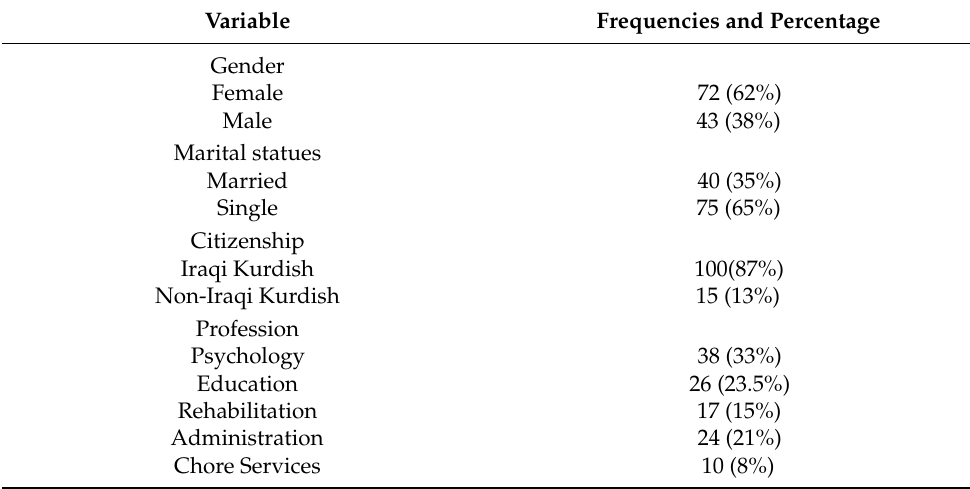
Table 1. The demographic information of the sample ( n =